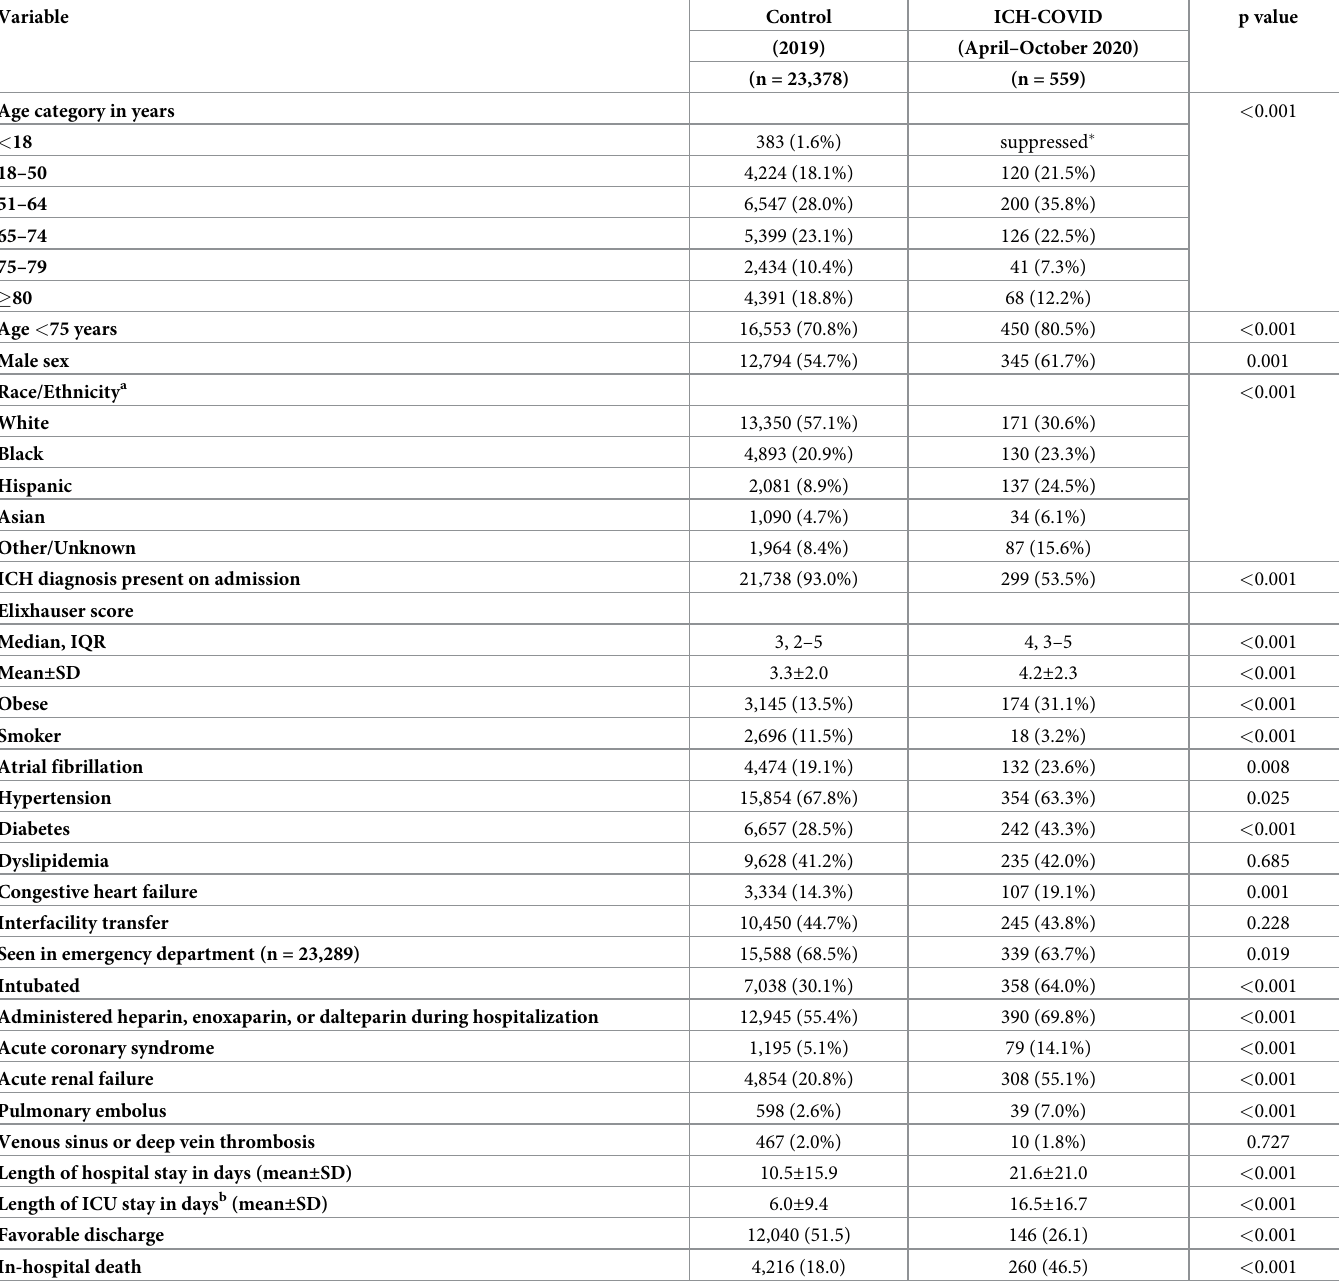
Table 1. Baseline demographics and outcomes of patients with intracerebral hemorrhage with or without COVID-19 infection.